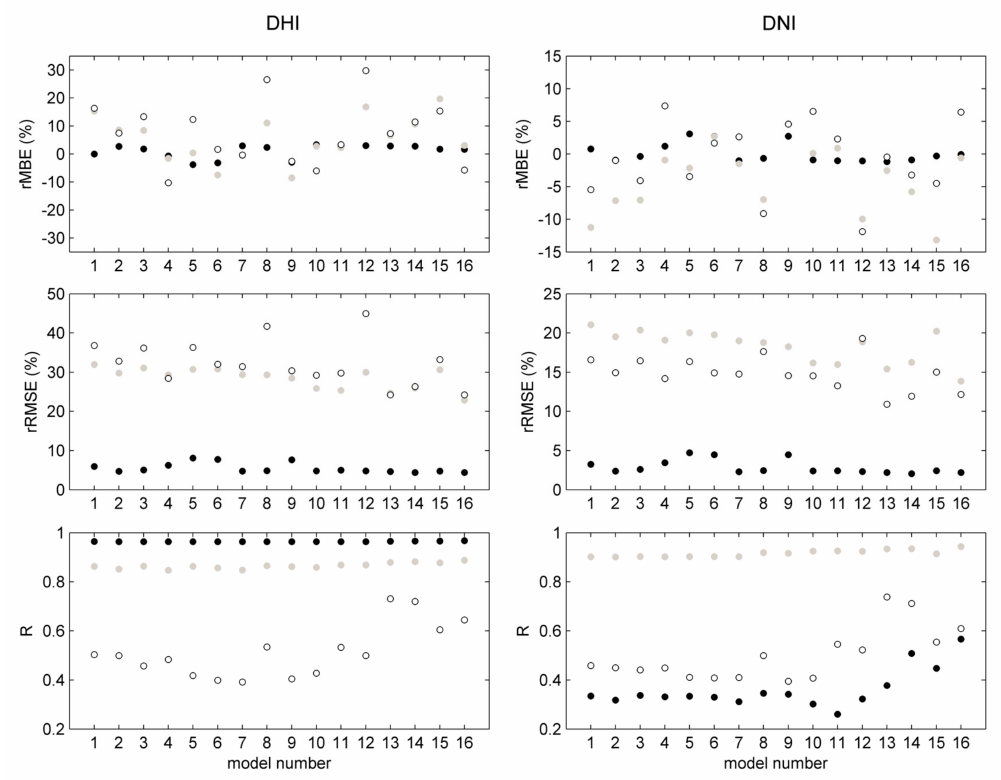
Figure 7. Performance statistics according to the different models (left: DHI; right: DNI) for three different intervals of k t . Black dots correspond to 0 < k t ≤ 0.3 (4705 data; overcast sky), grey dots to 0.3 < k t ≤ 0.7 (2623 data; partially cloudy sky), and empty dots to k t > 0.7 (2982 data; clear sky). See Table 1 for the numbers associated with the different